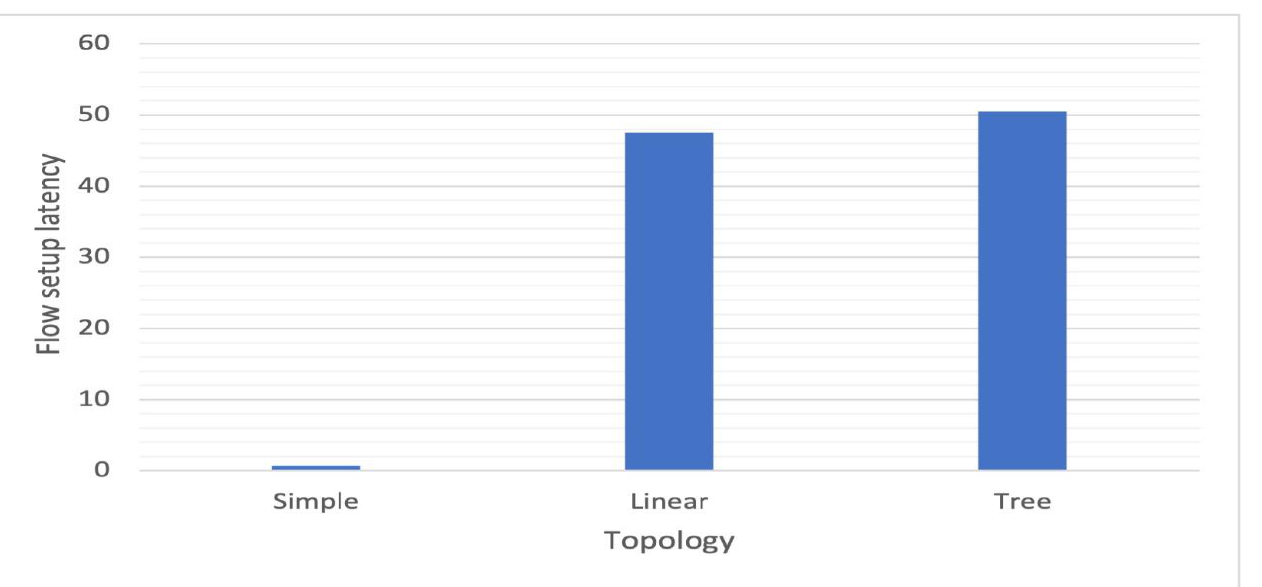
Figure 18. Graph showing flow setup latency with three topologies.